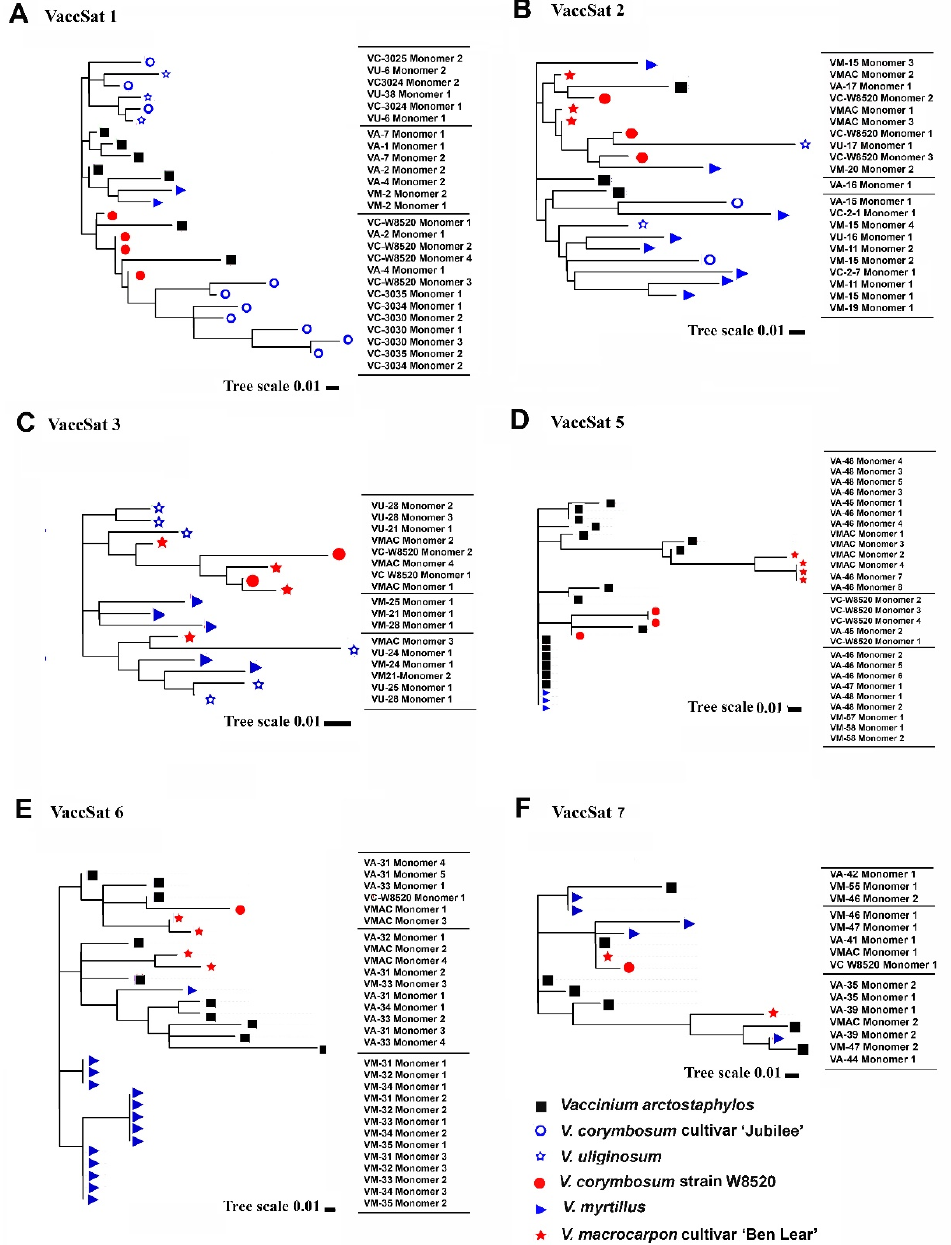
Figure 3. Phylogenetic analysis of satellite monomer sequences from different Vaccinium species using FastTree 2.1.5 [55]. ( A – C ) VaccSat 1–3; ( D ) VaccSat 5; ( E ) VaccSat 6; and ( F ) VaccSat 7. VA = V. arctostaphylos